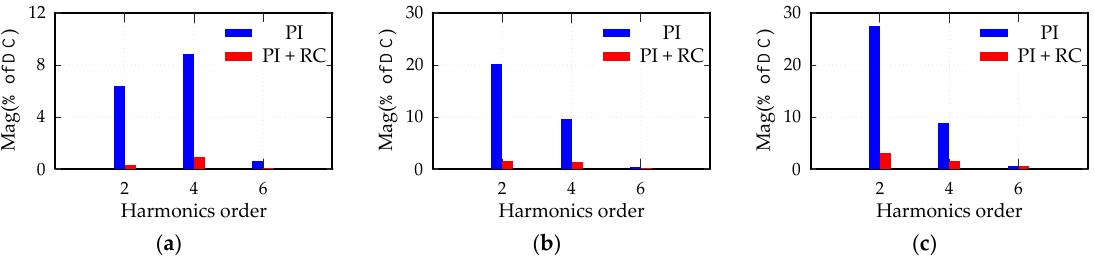
Figure 19. Harmonic components analysis of torque ripple before and after adding RC: ( a ) Harmonic components when the speed is 50 r/min; ( b ) Harmonic components when the speed is 300 r/min; ( c ) Harmonic components when the speed is 600 r/min. Table 2. Harmonic analysis result of the torque.